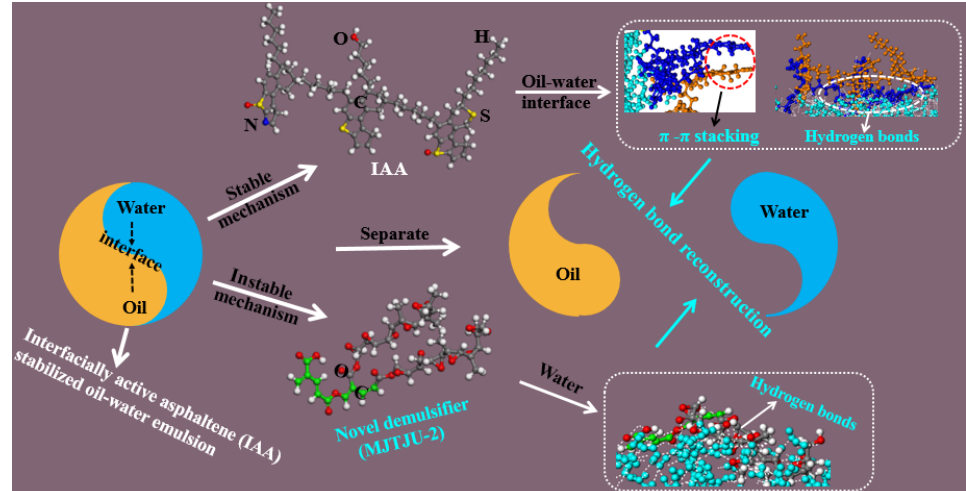
Figure 30. Schematic diagram of UHO separation mechanism construction.